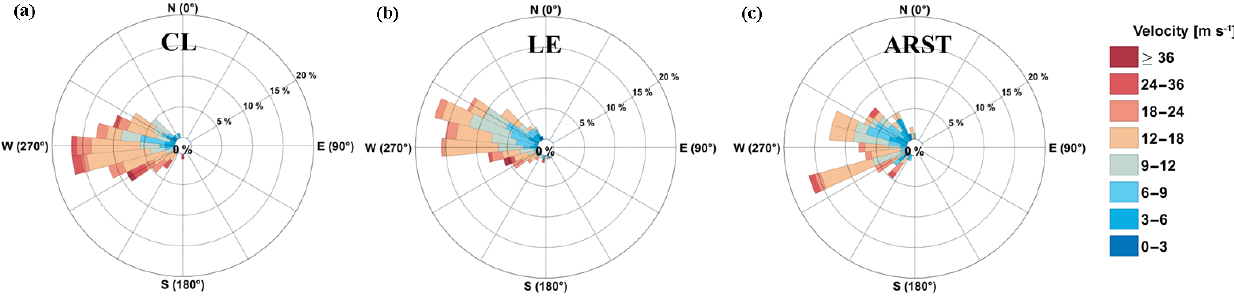
Figure 6. Advection (velocity and direction) distributions of CL (a) , LE (b) , and ARST (c) events.